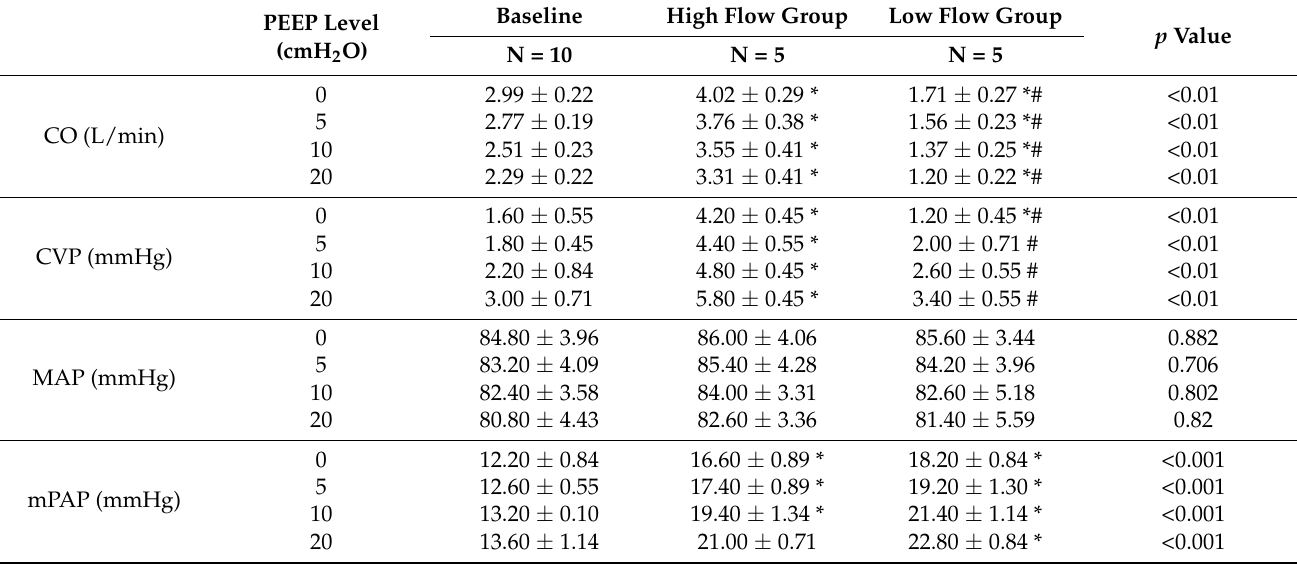
Table 4. Hemodynamic changes and transpulmonary capillary wall pressure. PEEP